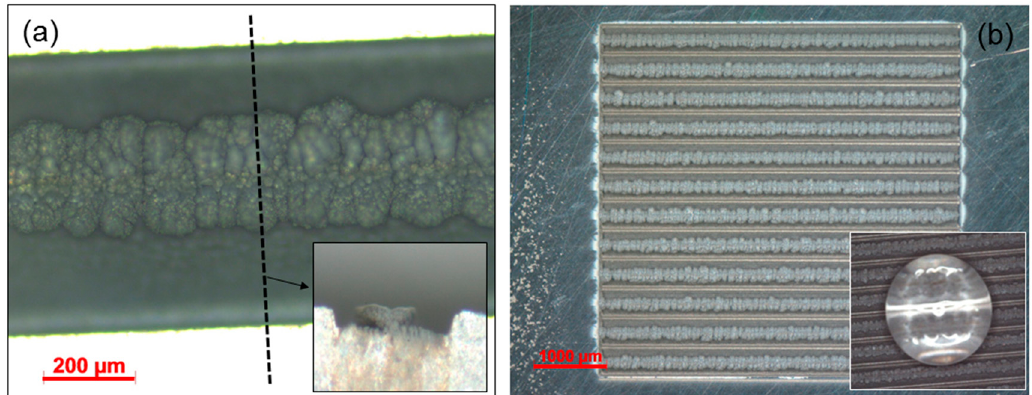
Figure 3. ( a ) Top view of the re-entrant structure realized by building the additive structures (AS) block from two sides. The dash line and the arrow are the visual indication of a cross-section. The inset is a cross-section of this re-entrant structure; ( b ) The structure unit shown in ( a ) is easily implemented on a large surface scale. This surface exhibits isotropic hydrophobicity (lower bottom inset).